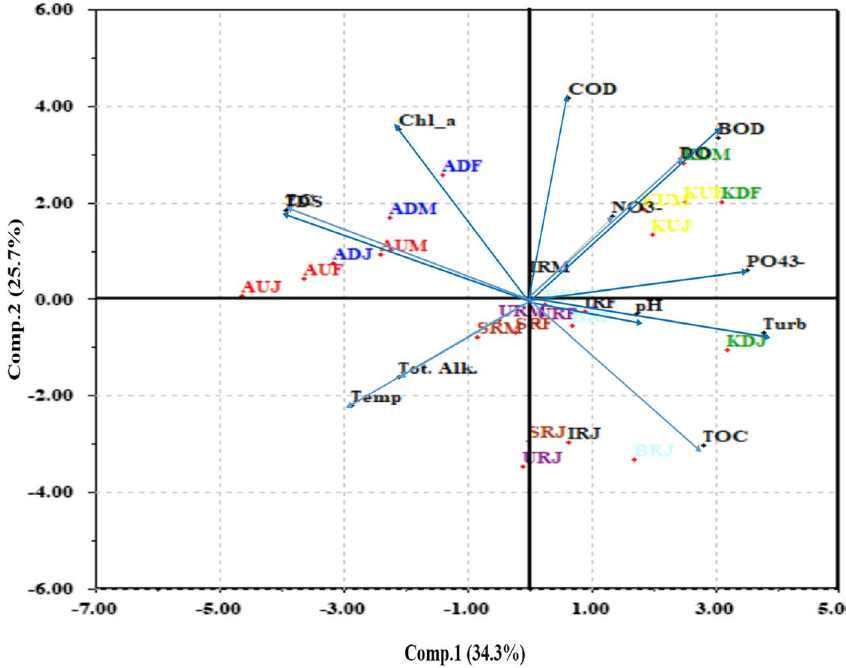
Fig. 4 Biplot of physicochemi- cal characteristics of water samples from Angereb River, Kokoch River and